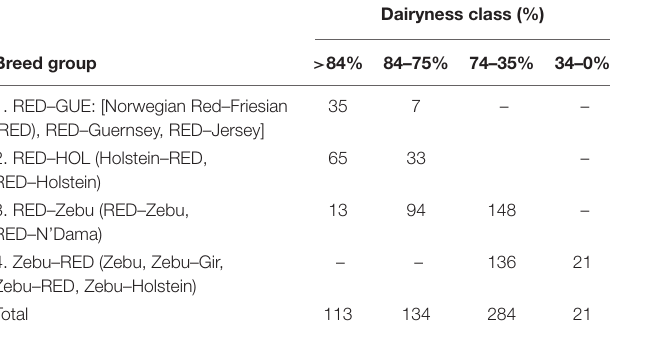
Dairyness class (%)